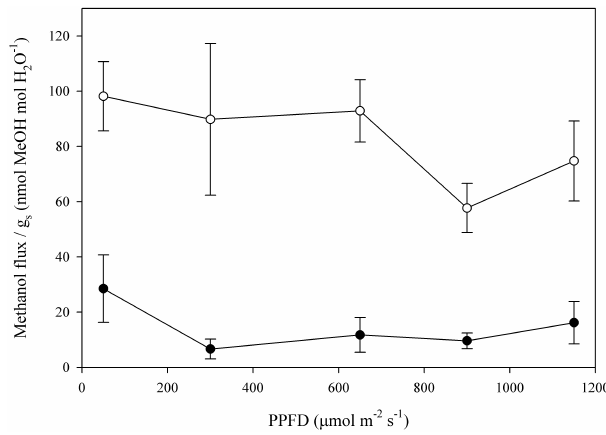
Fig. 3. Average MeOH flux values normalized for stomatal conduc- tance ( g s ) over five light levels for n = 5 mature (black circles) and immature (white circles) L. esculentum (standard error bars shown). PPFD had no significant effect on normalized MeOH flux ( F = 0 . 81 df = 4 P = 0 . 53). Plant type had a significant effect on normalized MeOH emission overall ( F = 79 . 43 df = 1 P < 0 . 0001).